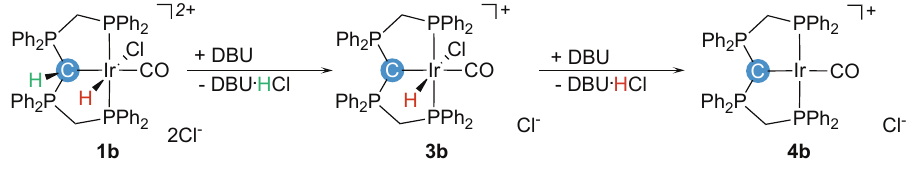
Figure 4. ( a ) Hydride region in the 1 H NOESY NMR spectrum at ambient temperature, showing chemical exchange correlations; ( b ) Equilibrium of the complexes in solution; ( c ) Van’t Hoff plot for the cis -/ trans -isomerisation of 1b ; ( d ) Eyring plot for the cis -/ trans -isomerisation of 1b .